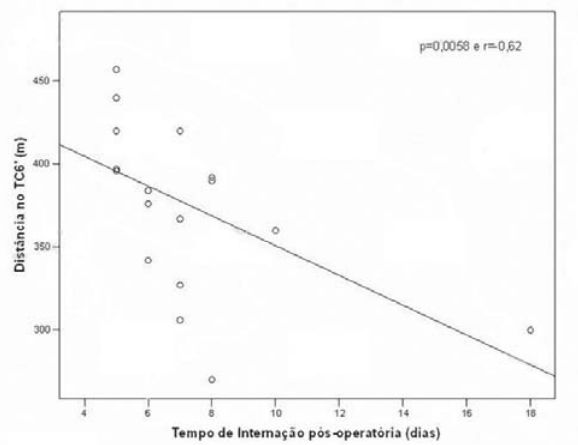
Fig. 1 – Correlação da distância percorrida no Teste de Caminhada de 6 minutos (TC6) com o tempo de internação pós-operatória (n=18)